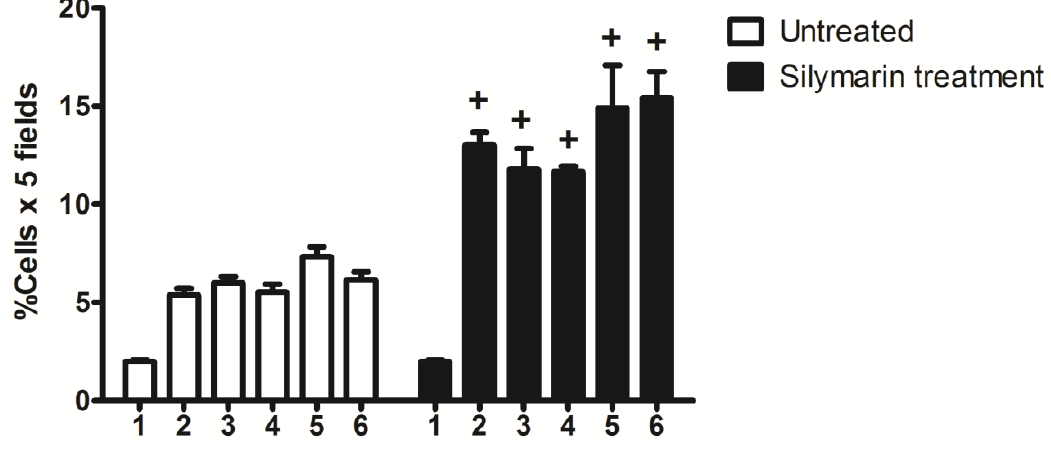
Figure 4. Nkx6.1 immunolabeled cells were counted as percentage of total cells in each field with five fields of each animal pancreatic tissue at different times after pancreatectomy: (1) control; (2) 3 days; (3) 7 days; (4) 14 days; (5) 21 days; (6) 63 days. + p < 0.05 treated versus untreated animals at the same times. n =